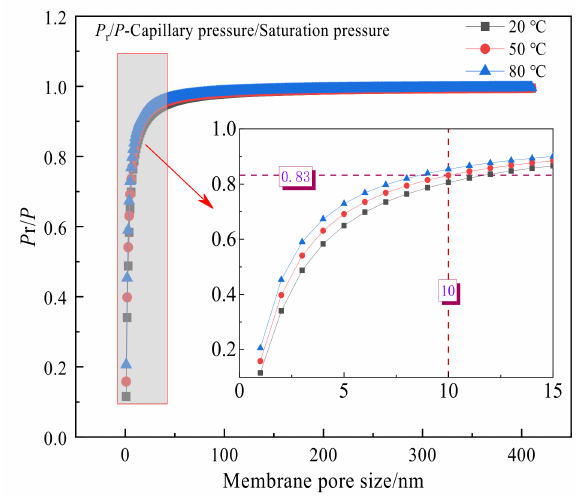
Figure 7. Capillary condensation pressure in the pore size.